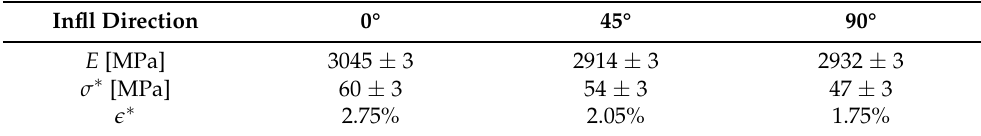
Table 4. Elastic characterization of contoured